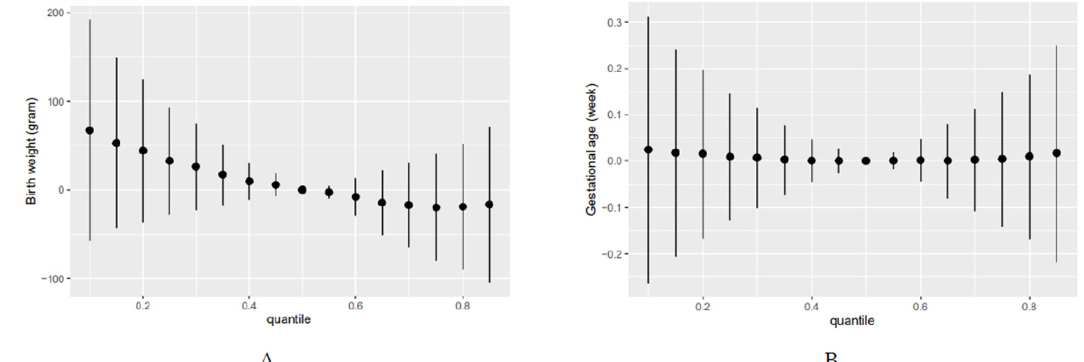
Figure 3. Overall effect of bisphenol mixture (BPA, BPF, BPS) exposure on the birth weight ( A ) and gestational age ( B ) (estimates and 95% credible intervals) by Bayesian kernel machine regression. This plot compares the change in the birth outcomes when all bisphenol exposures are at a particular quantile ( x -axis) compared to when all bisphenols exposure are at 50th percentile.